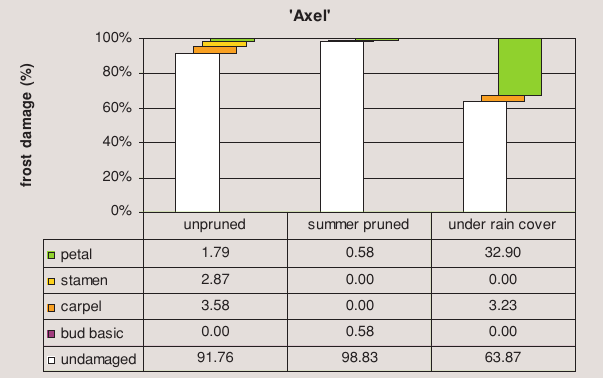
Figure 4. Frost damage in buds of the variety ’Axel’ observed on trees in 2011